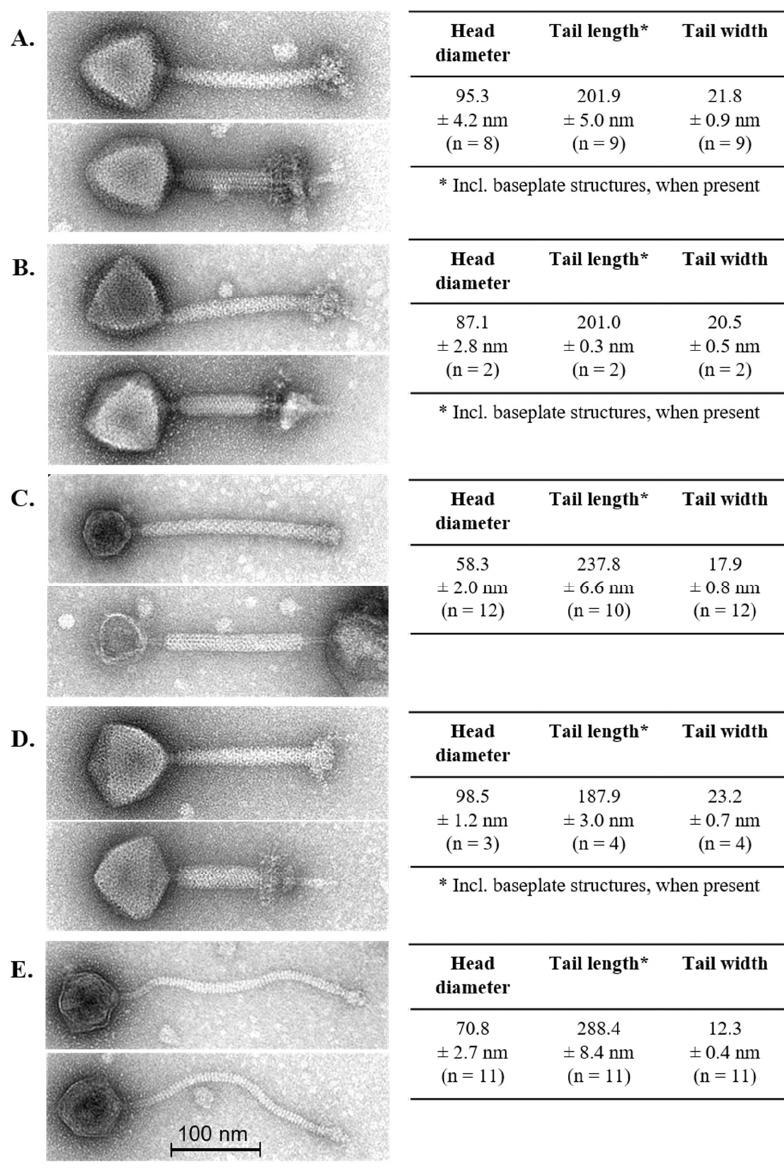
Figure 1. Electron micrographs of lytic Lb. brevis phages 3-521 ( A ), 521B ( B ), 3-SAC12 ( C ), SAC12B ( D ) and ATCCB ( E ). Head diameter, tail length and width are also indicated, where “n” represents the number of phage particles measured. For phage 521B and SAC212B, only few particles were detected with original extended tail sheaths (i.e., 2–4 particles). Tail lengths of phages 3-521, 521-B and SAC12B are also including the complex baseplate structures.